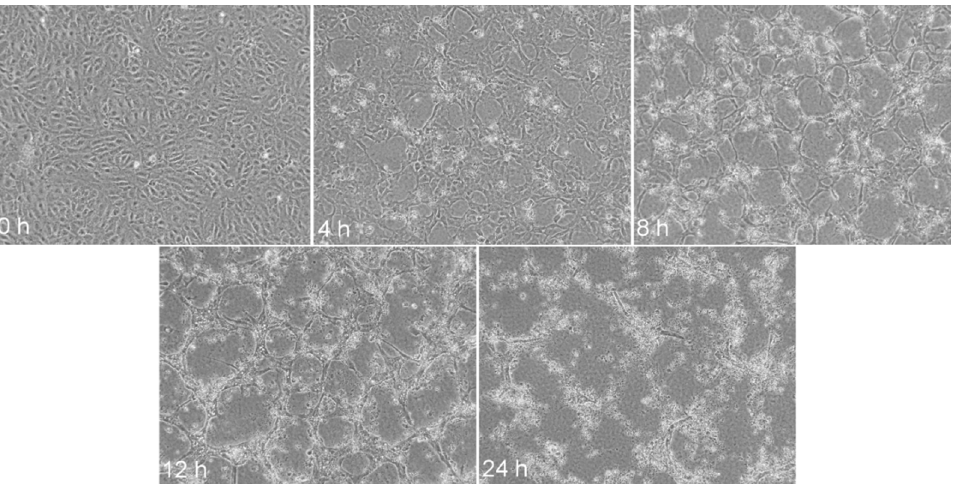
Figure 9. Apical collagen gel induces angiogenesis of human endothelial cells. Confluent monolayers of cells were overlain with a type I collagen gel at 0 h. At 2–4 h, cell streaming and reorganization occurred. At 6–8 h, cultures were at least about 50% reorganized and at 12–24 h, capillary tube formation was complete. Bar = 50 μm. Reprinted with permission from [107].